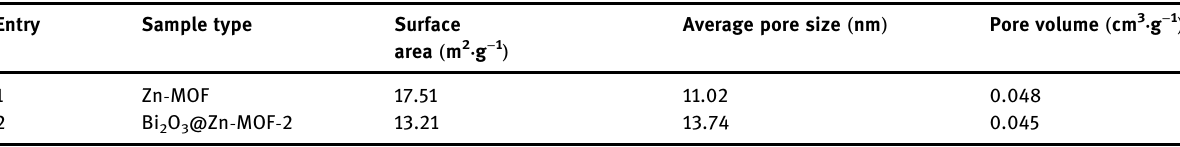
Table 1: Textural parameters of Zn - MOF and Bi 2 O 3 @Zn - MOF - 2